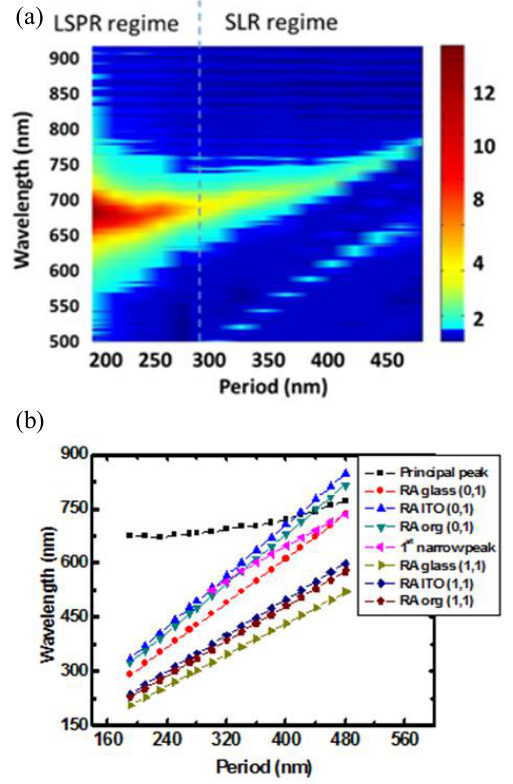
Fig. 1. (a) Extinction map of the Ag arrays as a function of the period and wavelength. (b) Variation of the LSP resonance, the first excited photonic mode and the appeared Rayleigh Anomalies as a function of the